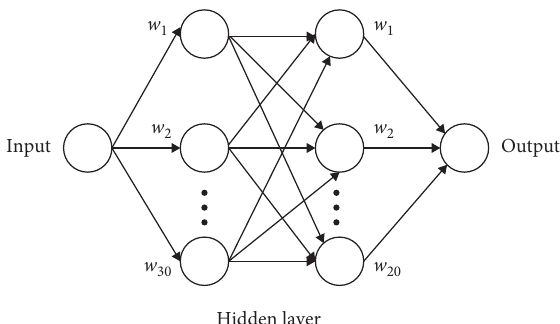
Figure 2: The structure of the double hidden layer neural network.